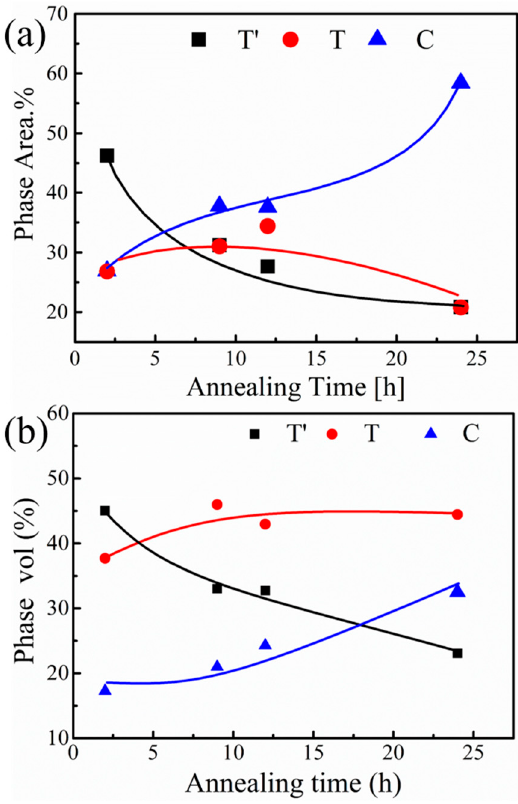
Figure 6. ( a ) The areas fraction of T ′ , T and C phases on the surface from the data of nanoindentation mapping. ( b ) Phase content of 8YSZ as a function of annealing time from XRD results.